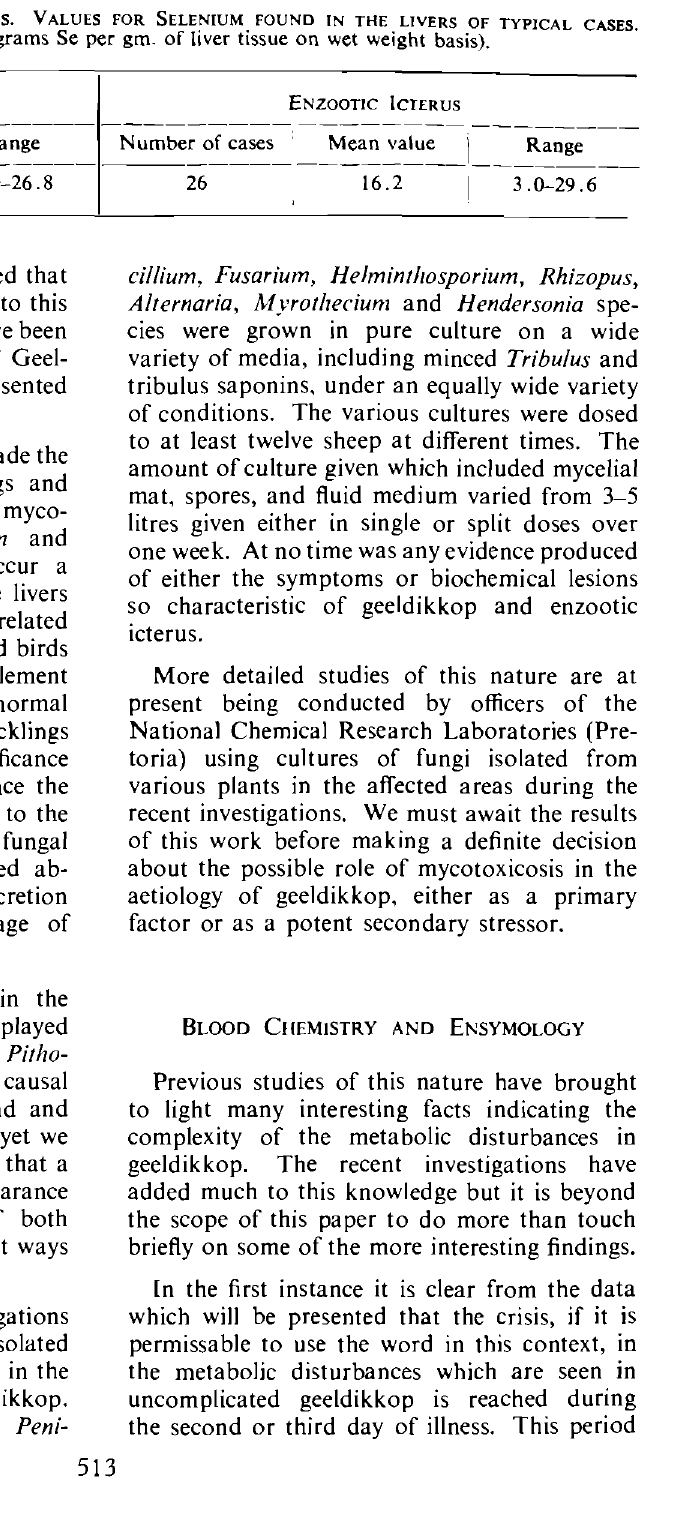
TABLE 2.-GEELDIKKOP A"'D ENZOOTIC JcrERUS. VALUES FOR SELENIUM FOUND IN THE LIVERS OF TYPICAL CASES. (Values are expressed as Micrograms Se per gm. of liver tissue on wet weight basis).